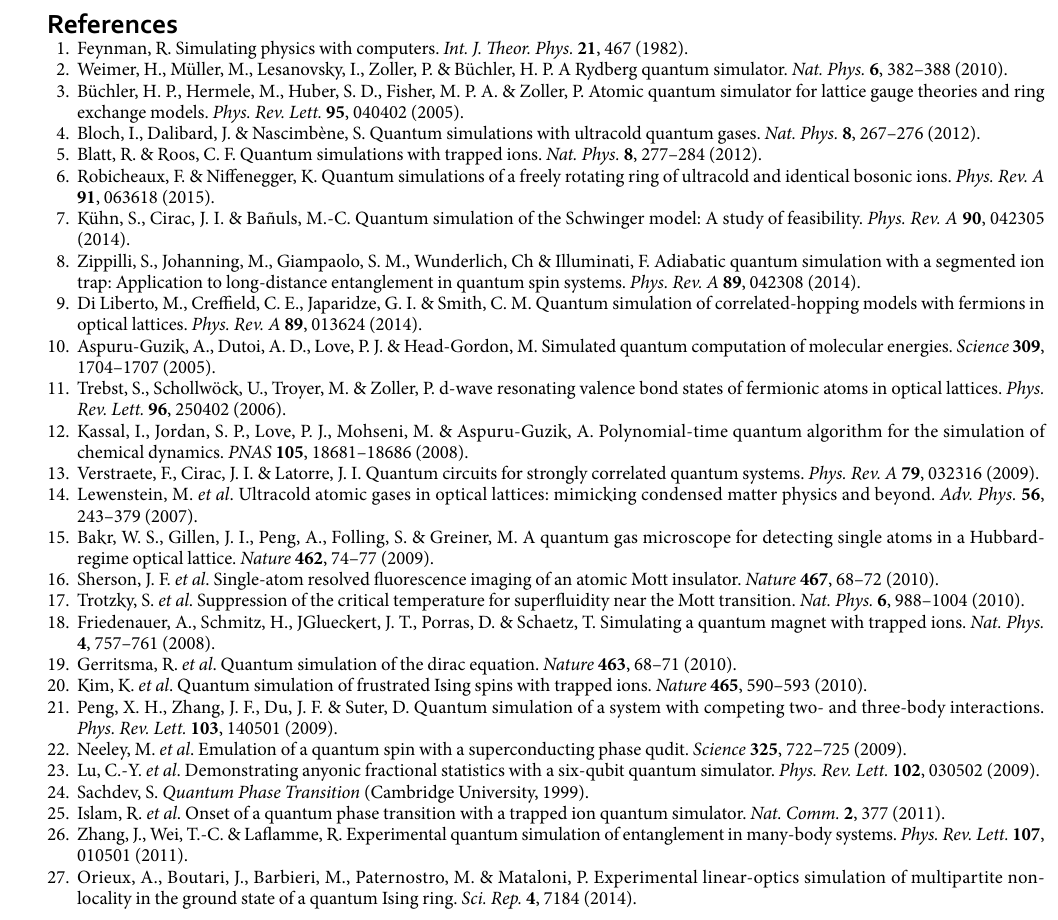
consists of generation of photonic entangled state with controllable coefficients and local operations. We tune the ratio of magnetic fields and coupling strength by changing local parameters to observe quantum state trans- portation: the ground state is transmitted from the ferromagnetically ordered high-field states to the entangled anti-ferromagnetic low-field states. This simulation of the Ising model with linear quantum optics might open the door to the future studies which connect quantum information and condensed-matter physics. To extend the method in our experiment to simulate the ground state of Ising-type N spins the major challenge is to generate systems with more photonic qubits. Recently the experimental generation of the 10-photon entangled states has been reported 36 . Thus our method can be extended to simulate the ground state of Ising-type N spins ( N ≤ 10) under the current technologies.